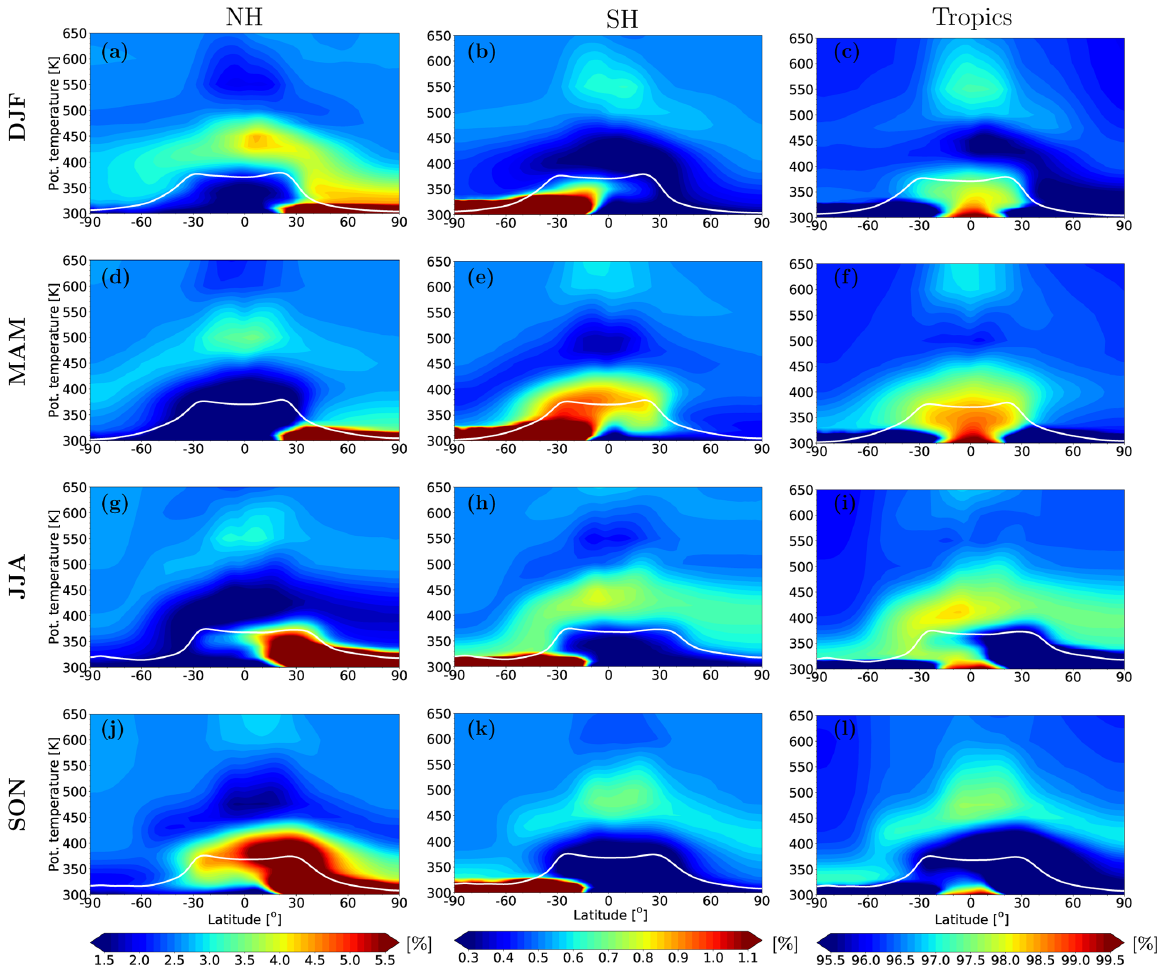
Figure 1. Climatological (1999–2017) zonal mean AMFs originated from the NH extratropics (a, d, g, j) , SH extratropics (b, e, h, k) , and tropics (c, f, i, l) for different seasons (rows). The AMFs for all three source regions add up to ∼ 1. The white line shows the WMO tropopause.